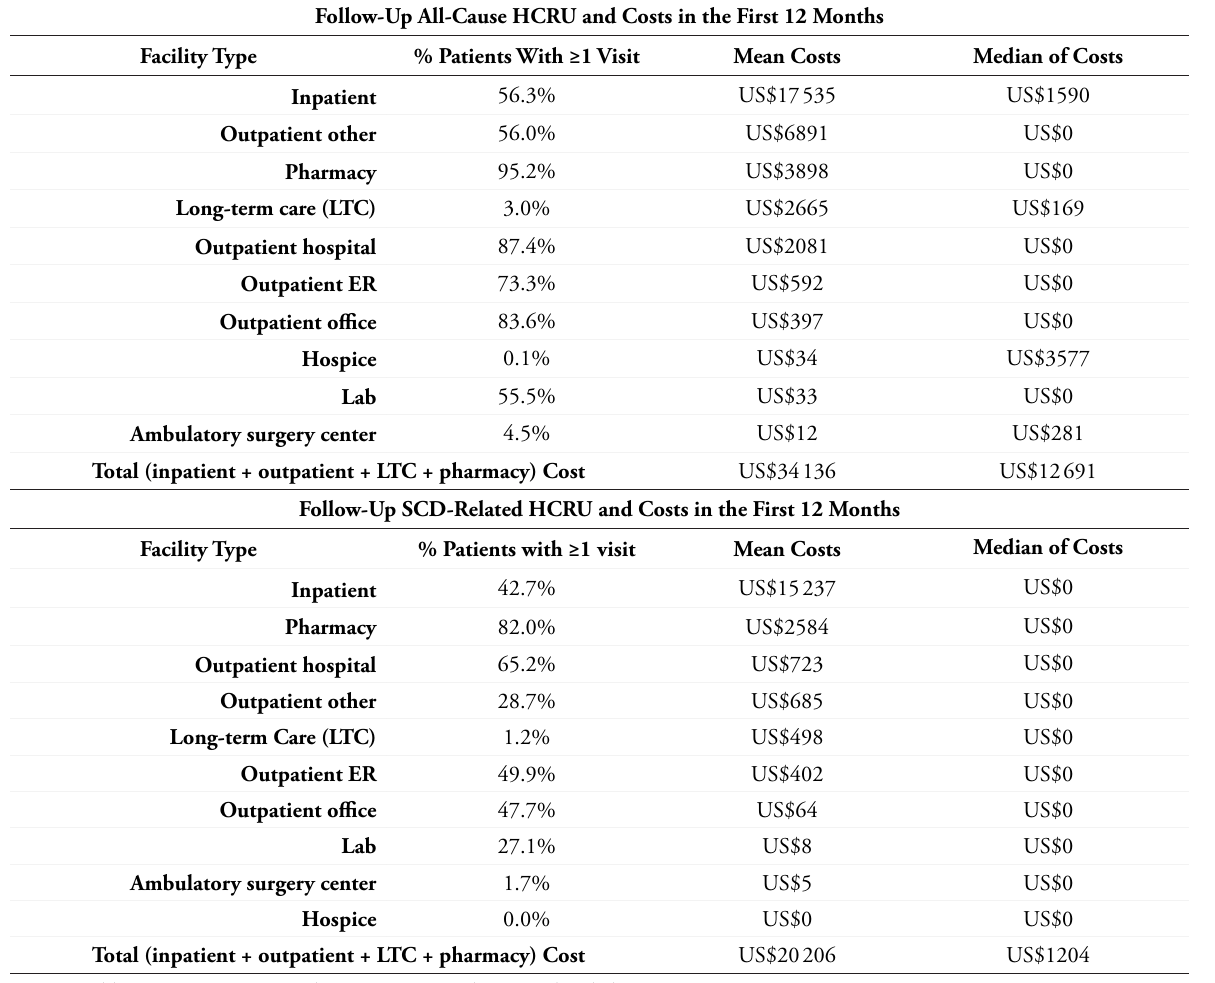
Table 3. Annual All-Cause and SCD-Related HCRU and